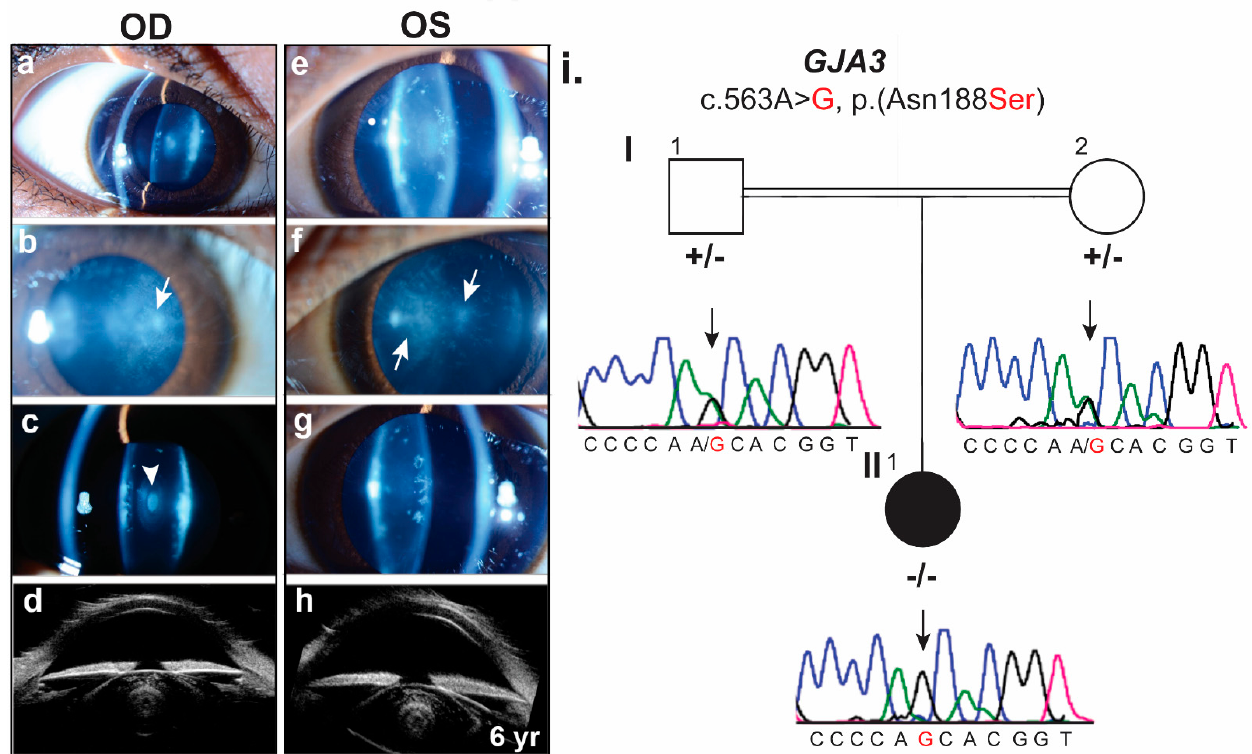
Figure 1. Clinical phenotype of proband affected by juvenile bilateral cataracts. ( a – h ) Slit lamp photographs of the OD (right) and OS (left) eye ( a – g ), respectively, demonstrate nuclear and cortical cataracts with dense fleck-like deposits in the anterior and posterior subcapsular regions, and diffuse “dust-like” pulverulent opacities (arrows). OD shows a small white central nuclear opacity (arrowhead; photographs courtesy of William Buie). Ultrasound images of OD and OS are shown in panels d and h, respectively. ( i ). Family of proband with CC showing segregation of GJA3 missense variant. The affected individual is shown by a filled symbol. Sanger sequencing DNA chromatograms of GJA3 for the heterozygous normal parents (I:1, I:2), and affected individual (II:1) are shown on the right